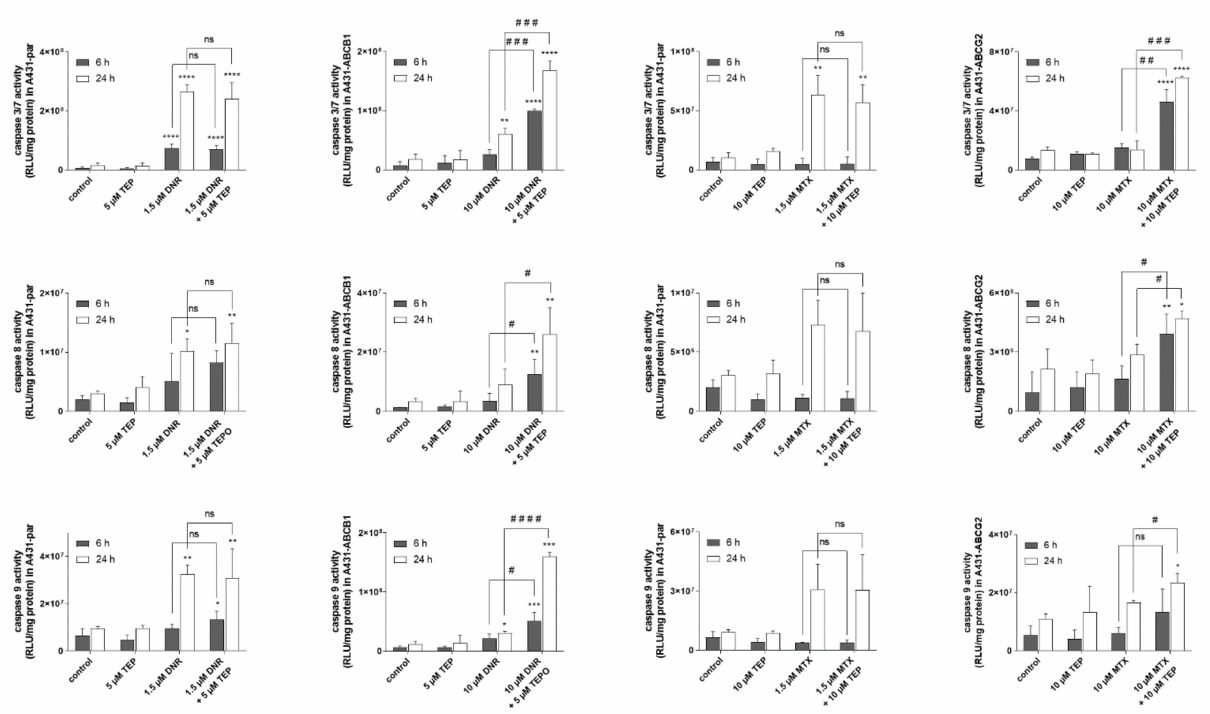
Figure 5. Caspases’ activities assessments. * one-way ANOVA followed by Dunnett’s post hoc test (comparison of all treated variants to control), # two-tailed unpaired t -test (single drug vs. combined treatments). DNR, daunorubicin; F A , fraction of cells affected; MTX, mitoxantrone; TEP,